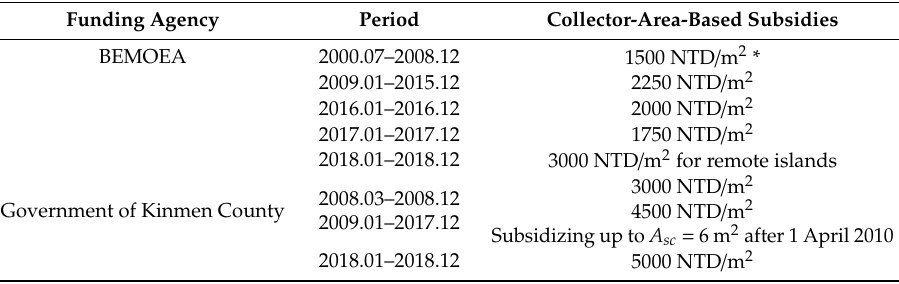
Table 1. Purchase-based subsidy programs in Taiwan and Kinmen (2000–2018).